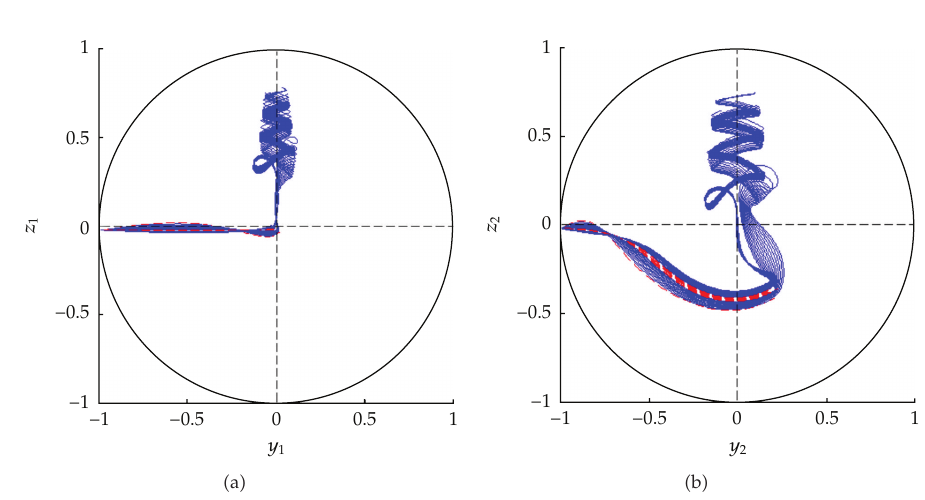
Figure 4: It is the same as Figure 3, but the singular flow is followed for longer times to show the attracting property of the north pole for the singular flow.